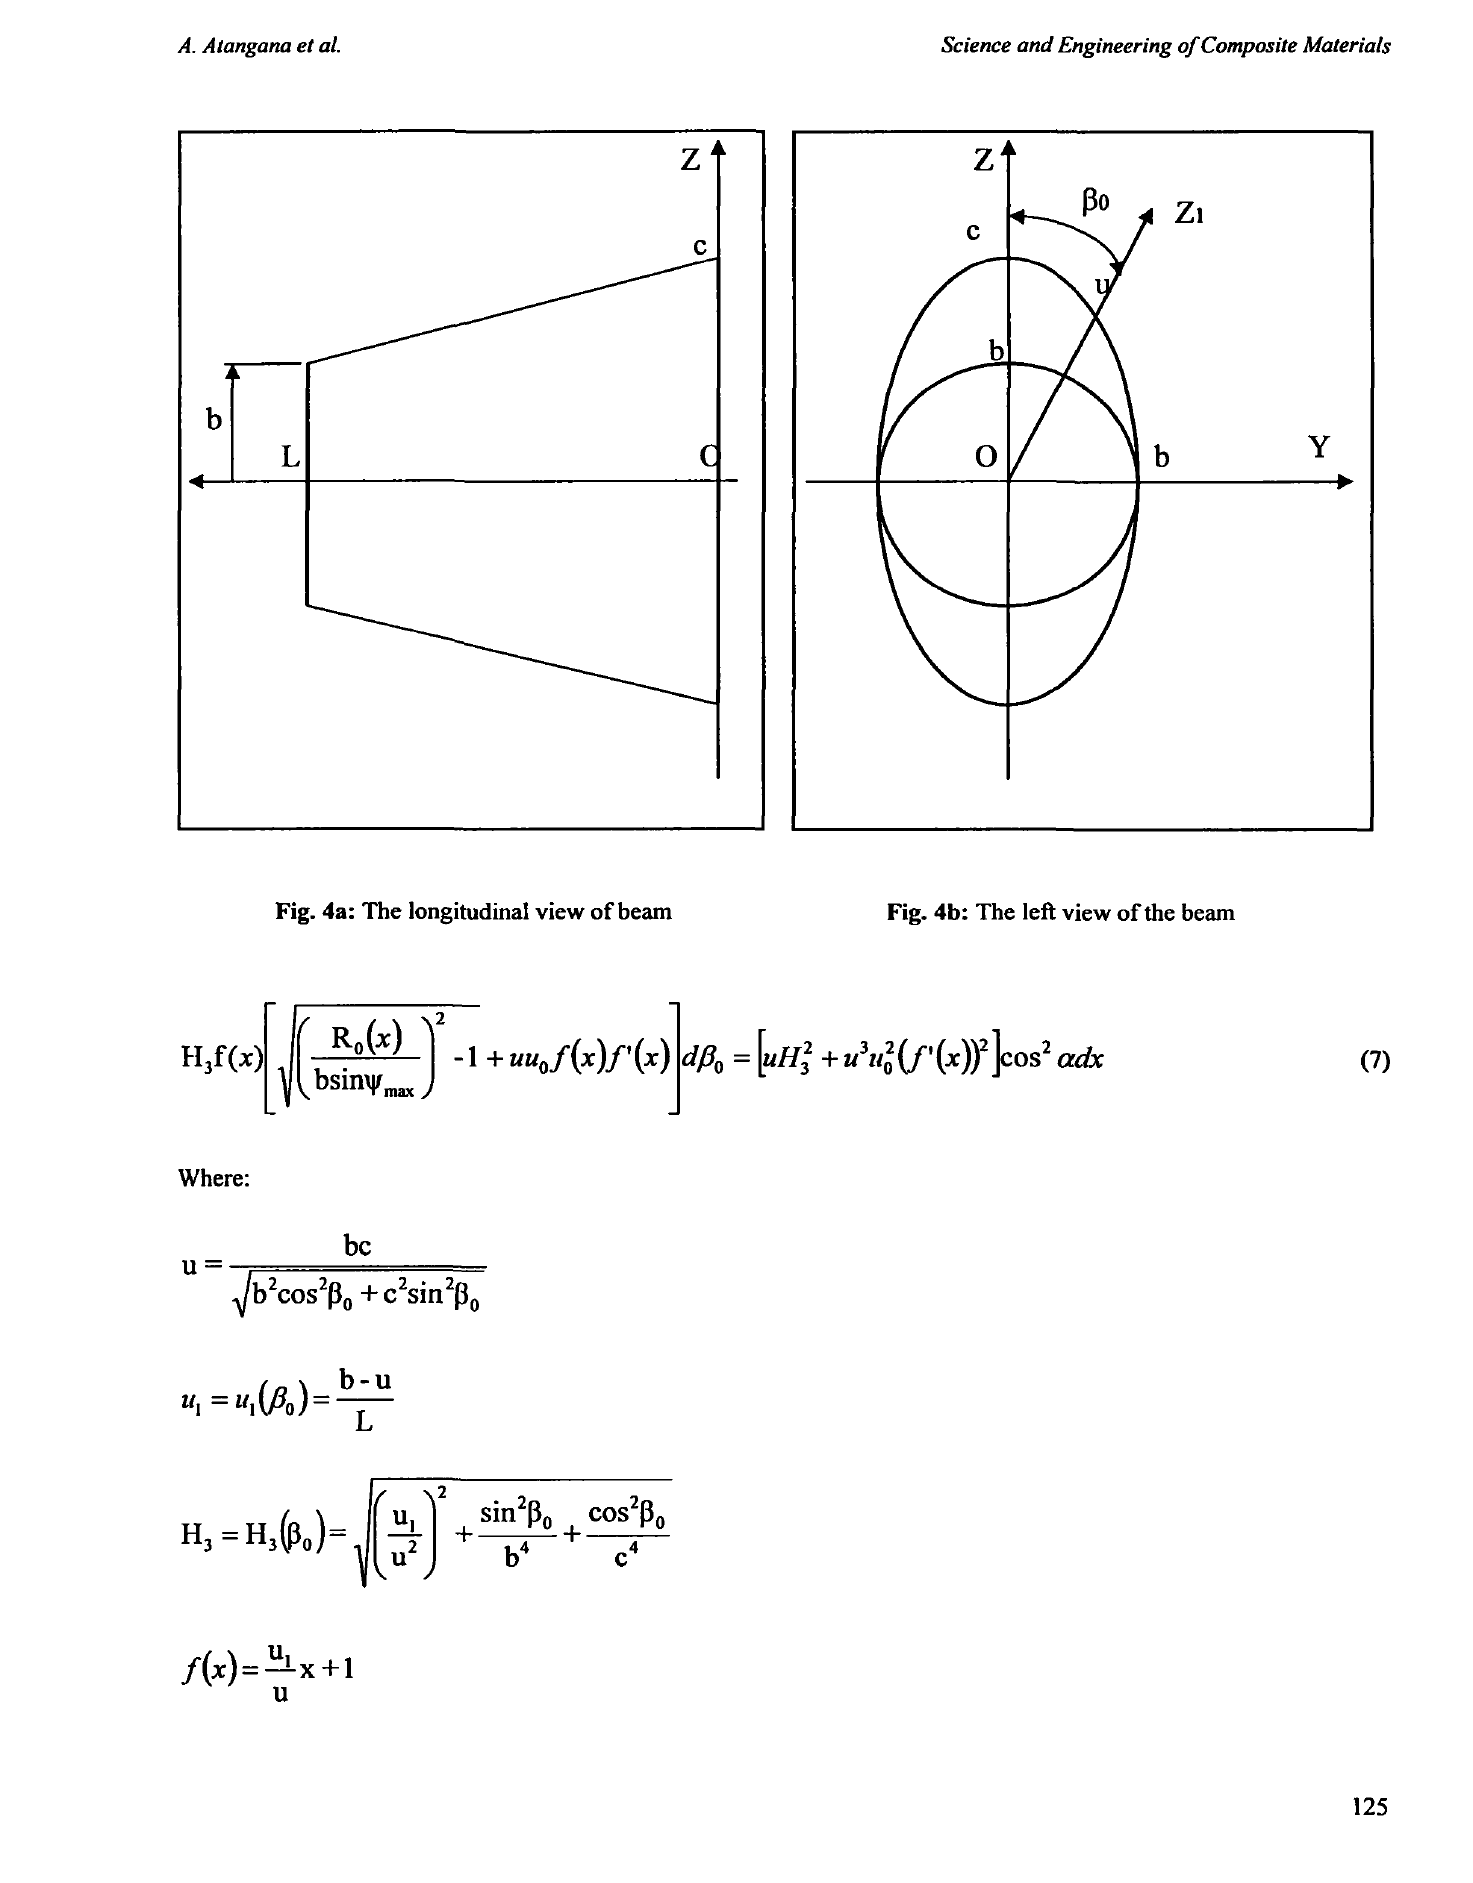
Fig. 4a: The longitudinal view of beam Fig. 4b: The left view of the